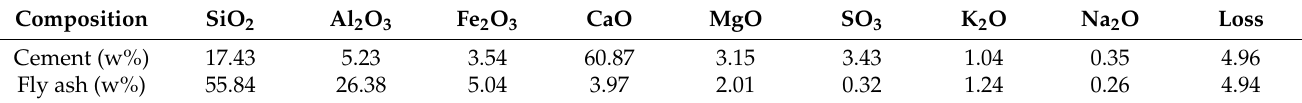
Table 2. The chemical composition of the ordinary Portland cement and fly ash.